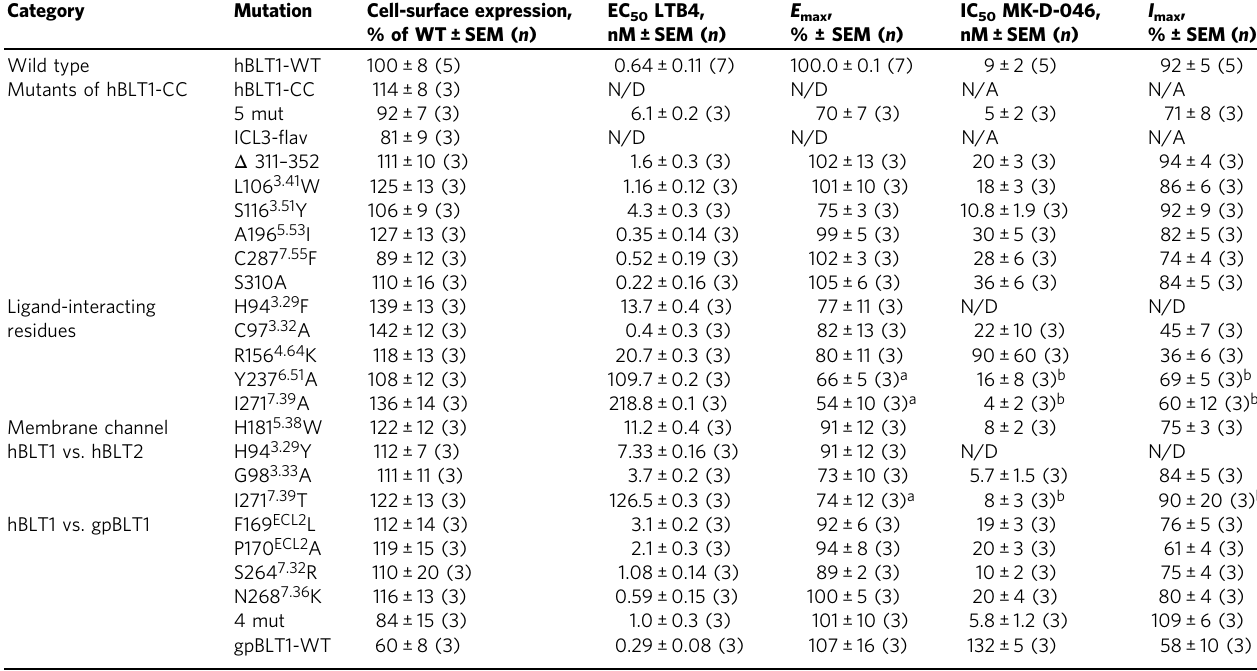
Results are expressed as mean ± SEM from at least three independent experiments carried out in triplicate (cell-surface expression data) or quadruplicate (signaling data). The number of independent experiments ( n ) is shown in parenthesis. Cell-surface expression values of mutants are reported as % of hBLT1-WT. hBLT1 or hBLT2 human leukotriene B4 receptor 1 or 2, gpBLT1 guinea pig BLT1, IP 1 myo-inositol 1 phosphate, LTB4 leukotriene B4, WT wild type, EC 50 and E max potency and ef fi cacy of LTB4, IC 50 and I max potency and ef fi cacy of MK-D-046 inhibition of LTB4-induced IP 1 production, N/D not determined, N/A not available, CC crystallization construct, 5 mut 5 mutations from hBLT1-CC (L106 3.41 W, S116 3.51 Y, A196 5.53 I, C287 7.55 F, and S310A), ICL3- fl av ICL3- fl avodoxin, Δ 311 – 352 truncation of hBLT1 residues 311 – 352, 4 mut 4 non-conserved residues in the hBLT1 binding pocket mutated to their gpBLT1 equivalents (F169 ECL2 L, P170 ECL2 A, S264 7.32 R, N268 7.36 K). a Maximal ef fi cacy at 1 μ M. b Tested with 1 µ M of LTB4 as EC 80 was >1 µ M.